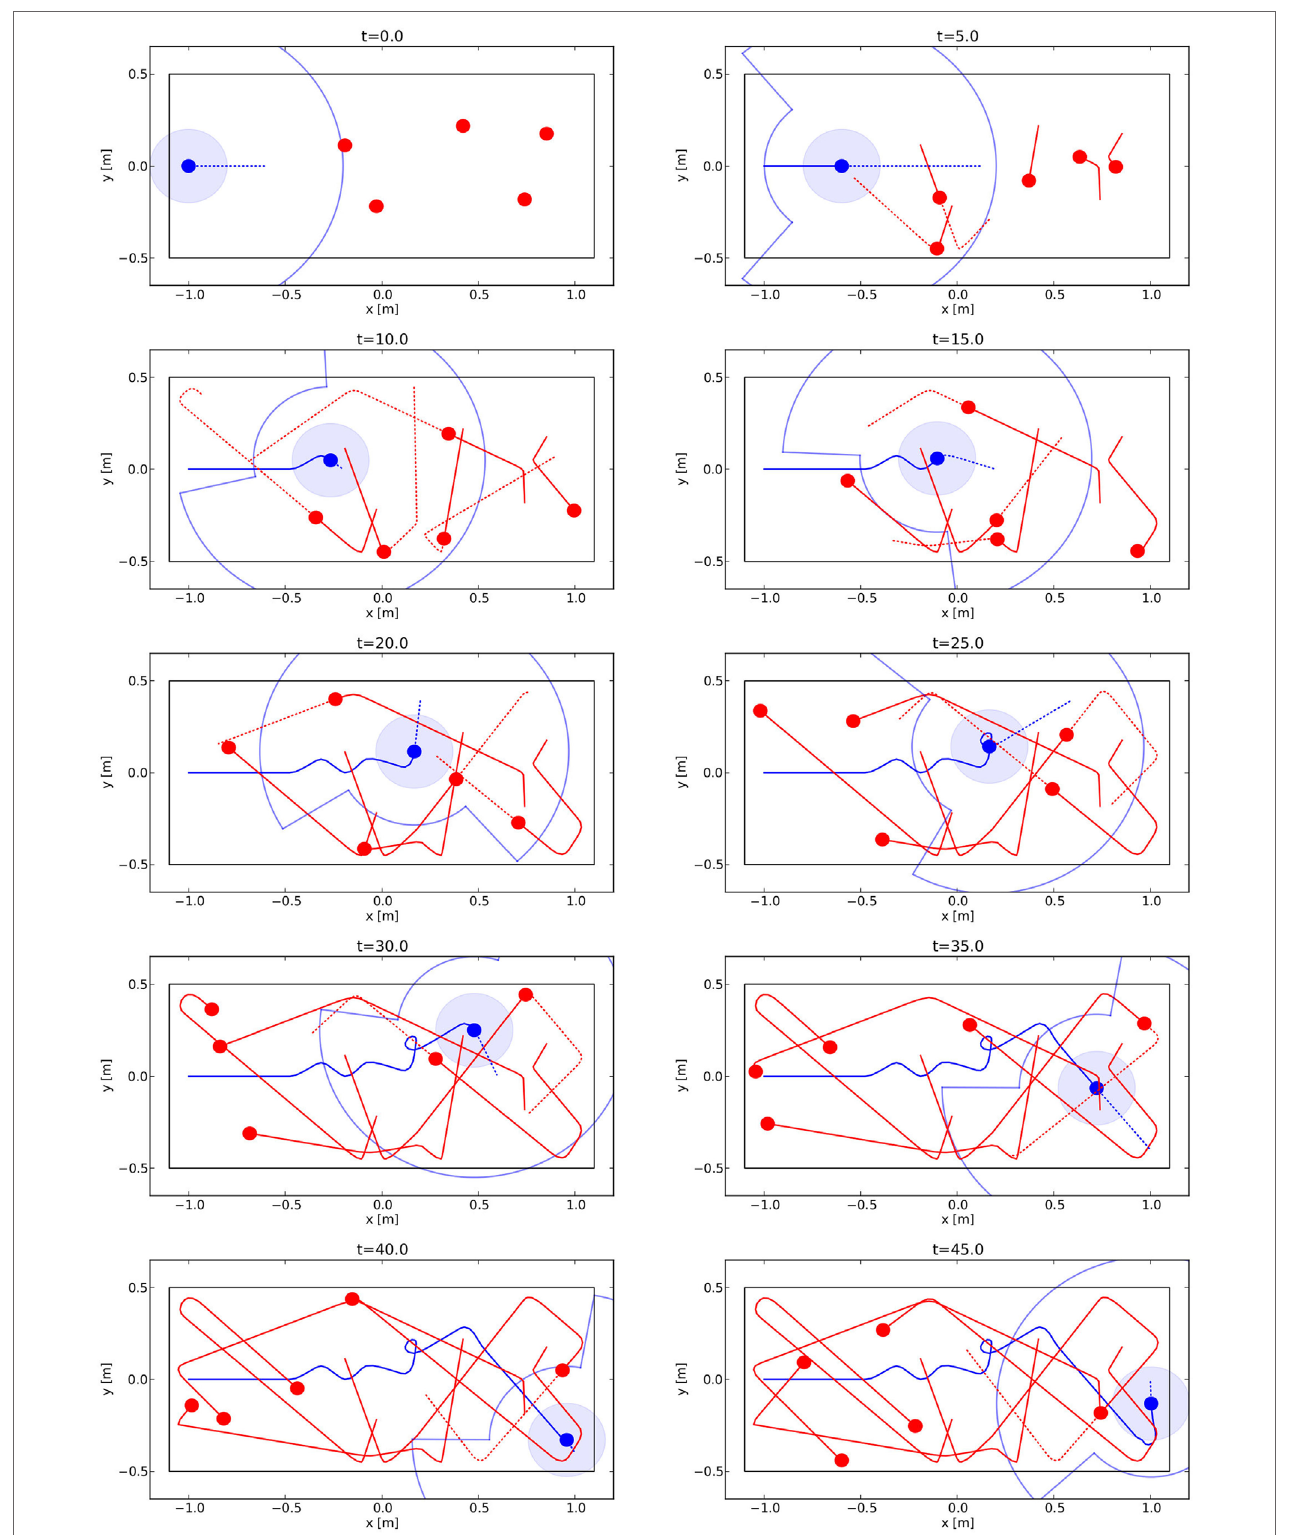
FigUre 12 | Trajectories for one experiment with a smart robot in simulation (for real experiments, please refer to Videos S1–S5 in Supplementary Material). The smart robot is depicted blue and the h-robots red. Solid lines are real trajectories, while dotted ones represent predicted trajectories. Only the simulation result for the best action is shown, together with attention radius (cf. Section 2.3.5) and safety radius.